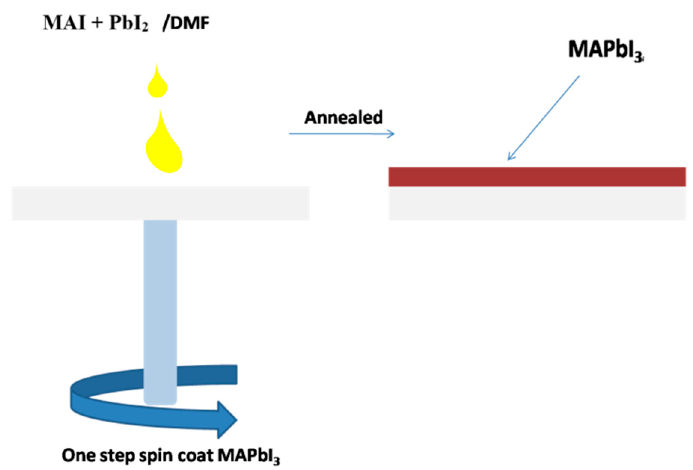
Figure 5. Schematic illustration of one-step solution processing method. Reprinted with permission from Ref [64]. Copyright (2020) Elsevier.